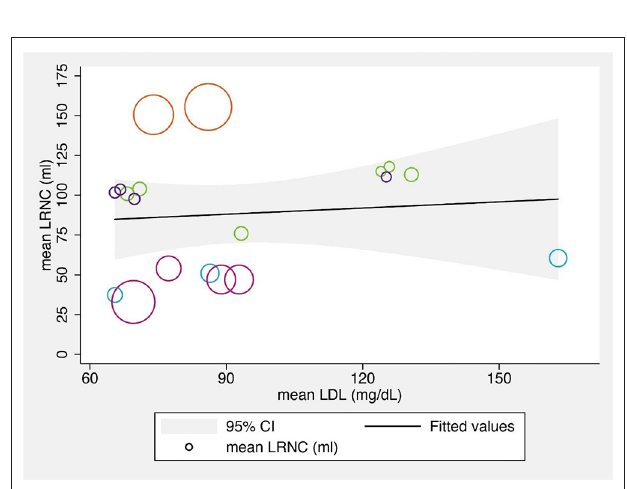
FIGURE 4 | The bubble chart about the relationship between mean LRNC volumes and mean LDL-C